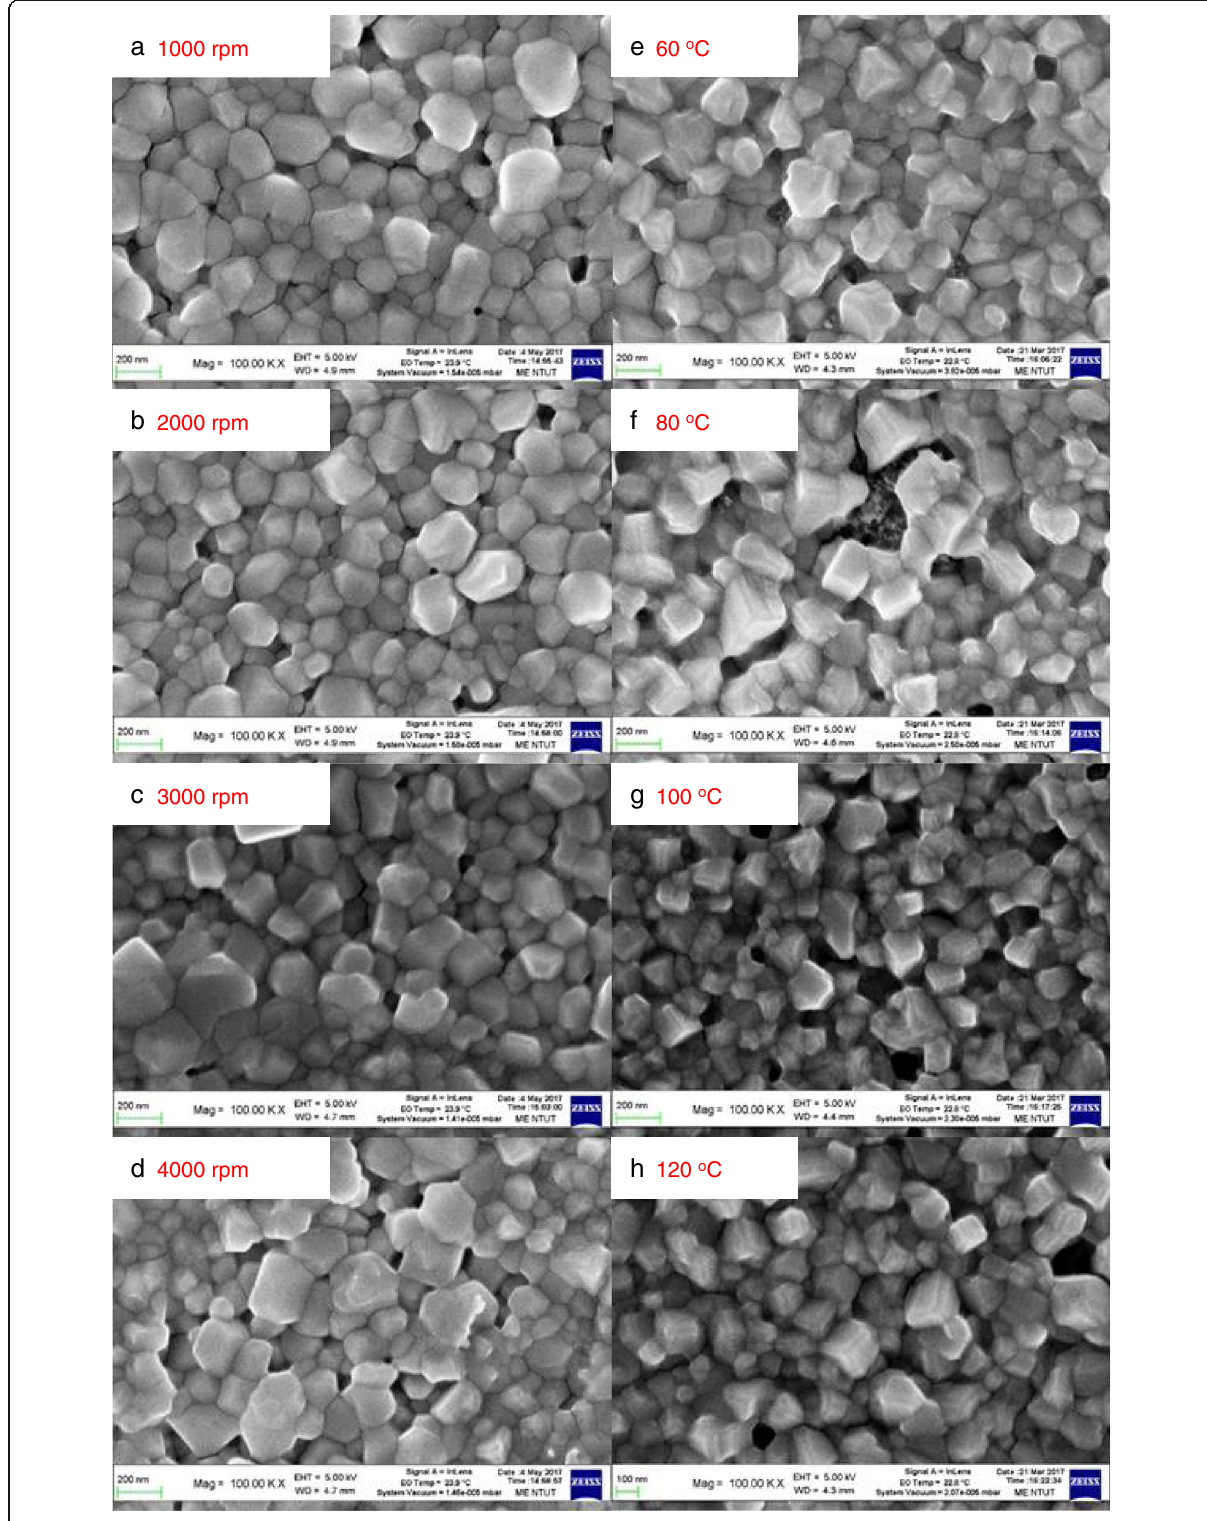
Fig. 2 Top-view SEM images of the MAPbI 3 perovskite films prepared by low-concentration MAI (10 mg/mL) with a-d various spin coating speeds and e-h annealing